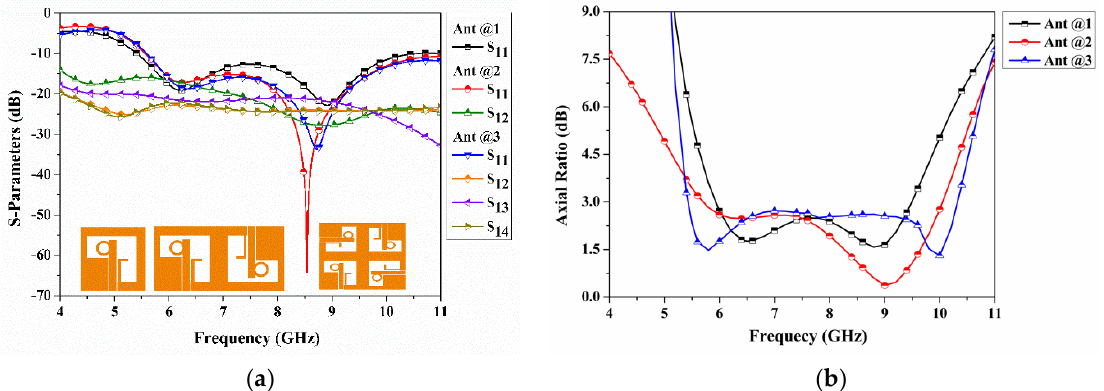
Figure 6. Scattering and axial ratio results for Ant @ 1, Ant @ 2, and Ant @ 3 ( a ) S-Parameters